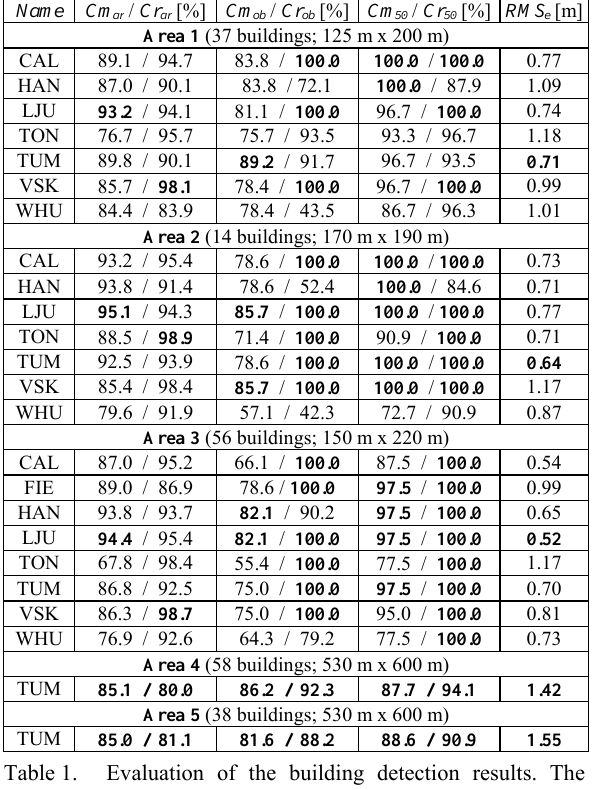
Table 1. Evaluation of the building detection results. The column headings are explained in Section 2.